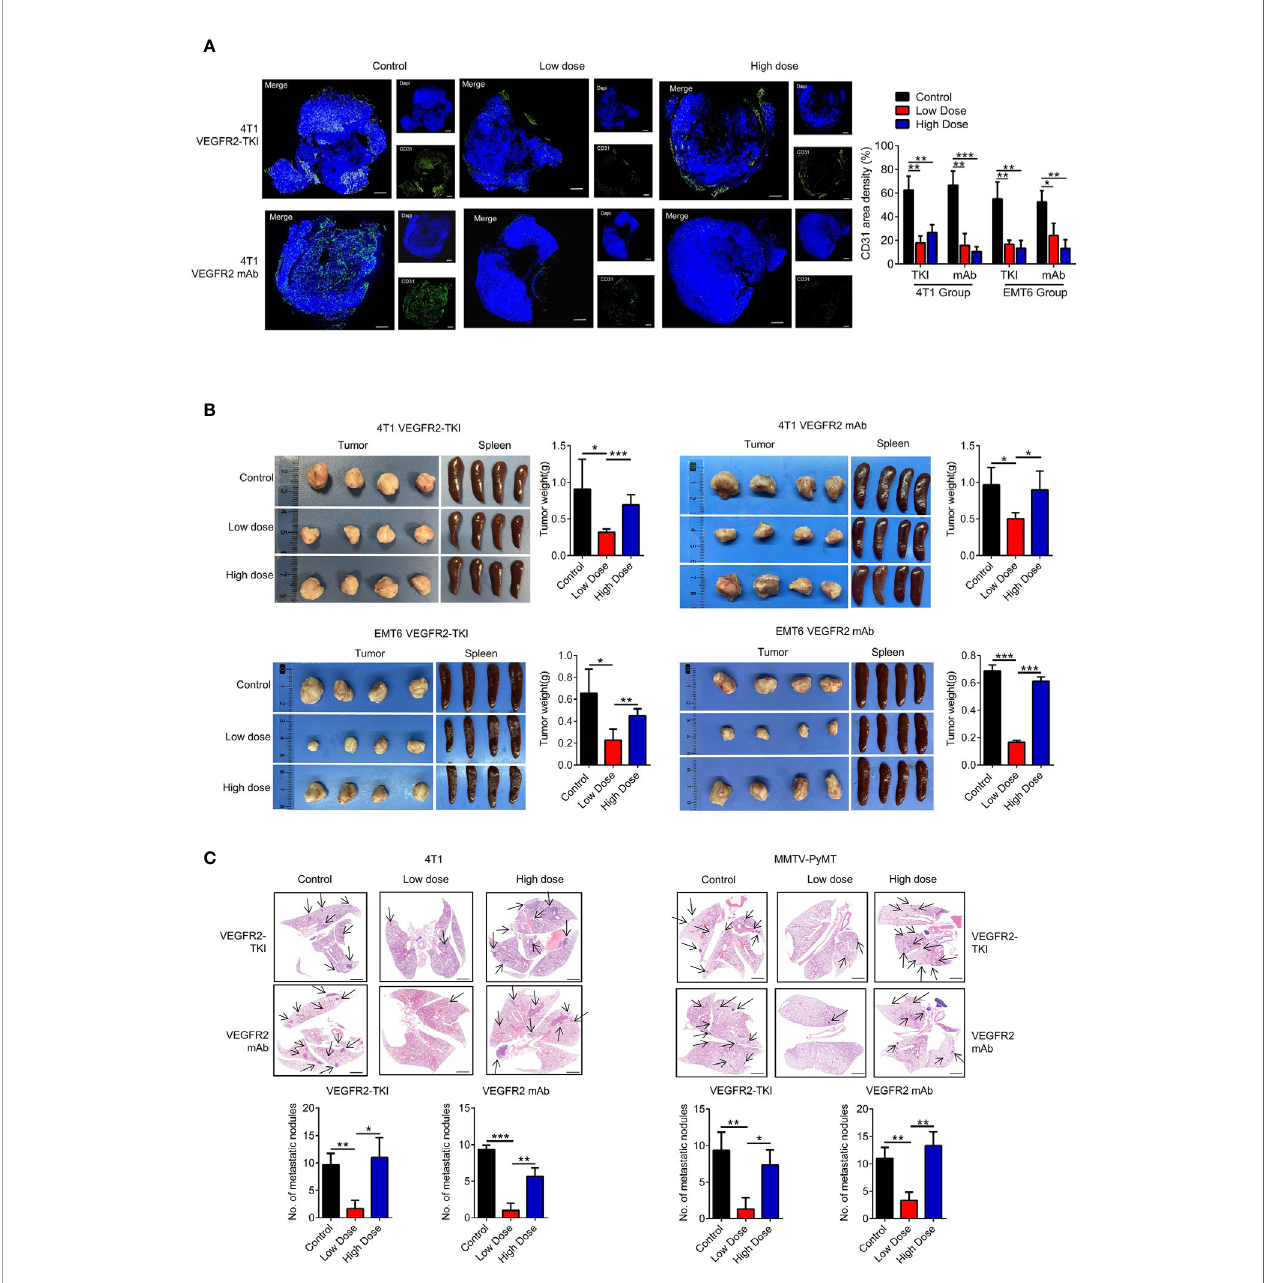
FIGURE 1 | High doses of anti-VEGFR2 therapy are not effective at controlling breast cancer progression. (A) Immuno fl uorescence and quanti fi cation of CD31 on breast cancer tissue after anti-VEGFR2 therapy in 4T1 model. Bar=200 m m. Green, CD31; blue, DAPI. (B) Representative size and weight of tumor and spleen after anti-VEGFR2 therapy. (C) H&E staining and quanti fi cation of lung metastasis in the 4T1 model (Black arrow) and MMTV-PyMT model (Black arrow) after anti-VEGFR2 therapy. Bar=1 mm. Data are presented as the means ± SD from one representative experiment. Similar results were obtained from three independent experiments, n=4 mice each group, unless indicated otherwise. Statistical analysis was performed by one-way ANOVA. *p < 0.05, **p < 0.01, and ***p < 0.001. See also Supplementary Figures S1 , S2